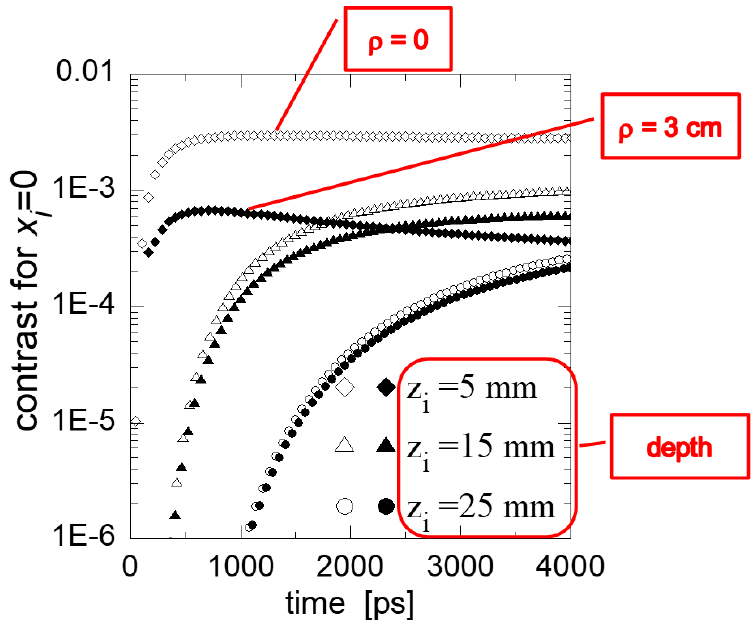
Figure 4. The ρ = 0 case improves contrast at all times with respect to a larger ρ (modified from [38]).